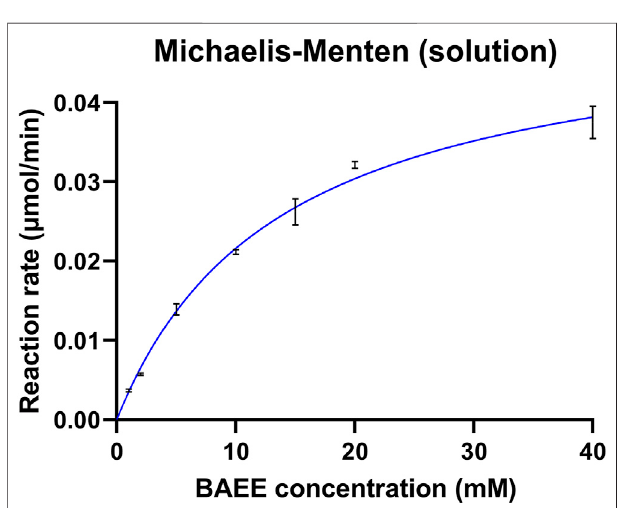
FIGURE 2 | Kinetic pro fi le of free papain. The enzyme was incubated with increasing concentrations of BAEE. Each point is the mean of three replicates, with error bars indicating ± standard